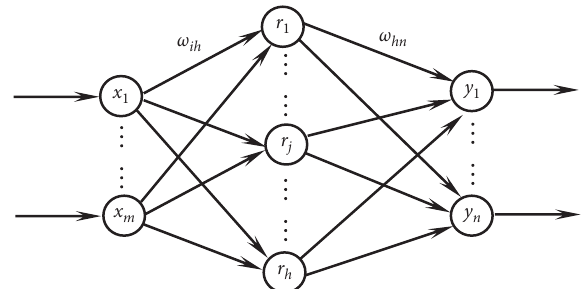
Figure 7: RBF network structure